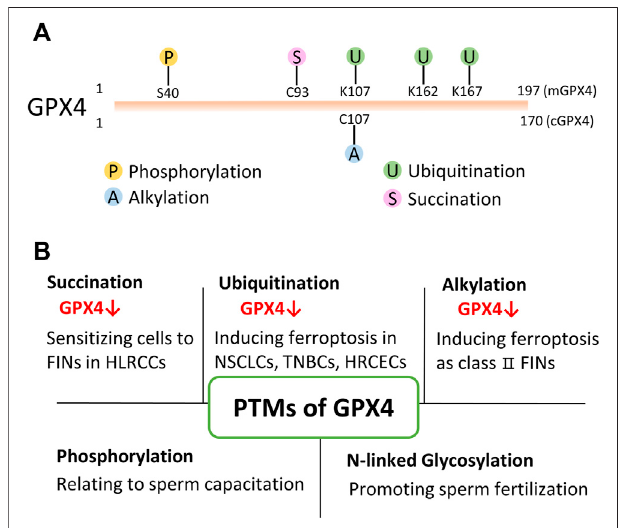
FIGURE 2 | PTMs of GPX4. (A) Present identi fi ed PTMs sites of GPX4 from proteomics and drug research. mGPX4: mitochondrial isoform; cGPX4: cytosolic isoform. (B) Various PTMs have been found to modify GPX4 protein and regulate its protein level/activity in physiological and/or pathophysiological conditions. HLRCC: hereditary leiomyomatosis and renal cell cancer; NSCLS: non-small cell lung cancer; TNBC: triple-negative and Stockwell, 2008), ML162 (Weïwer et al., 2012), and ML210 (Eaton et al., 2020), can directly inhibit GPX4 activity. They eventually lead to the accumulation of lipid peroxides without the reduction of GSH (Yang et al., 2014). Apart from these two types of FINs, other methods or compounds can also induce ferroptosis ( Figure 1 ): L-buthionine sulfoximine (BSO) suppresses glutamate-cycteine ligase (GCL) and induces GSH depletion (Seiler et al., 2008; Sun et al., 2018), driving cells to ferroptosis; Cystine starvation leads to glutamate accumulation, GSH biosynthesis reduction, and GPX4